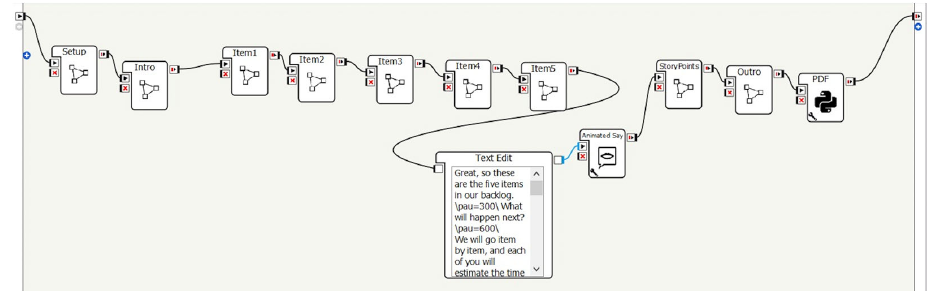
Figure 2. Design of “Planning poker with NAO” in Choregraphe. The fi nal version of the game “Planning poker with NAO” was published in an Open Source repository on GitHub (cf. Supplementary Materials).